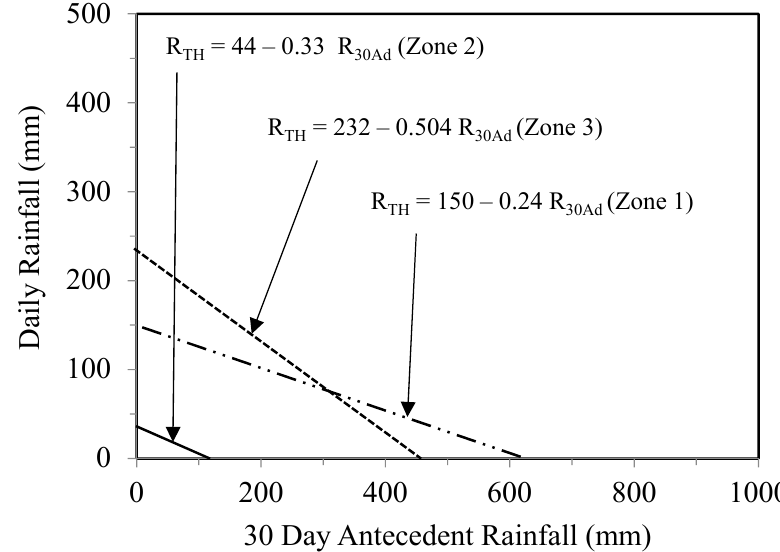
Figure 6. Threshold equation between daily rainfall and 30 day antecedent rainfall for all the three zones.